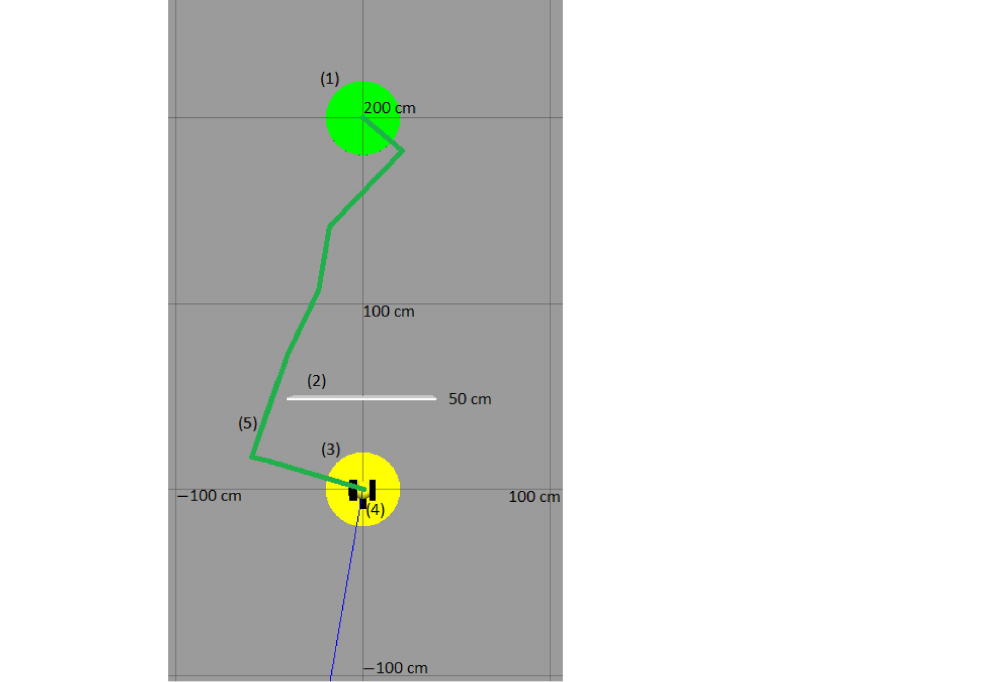
Figure 8. Trajectory in simulated scenario with one obstacle: (1) goal, (2) obstacle, (3) home, (4) robot, and (5) trajectory.